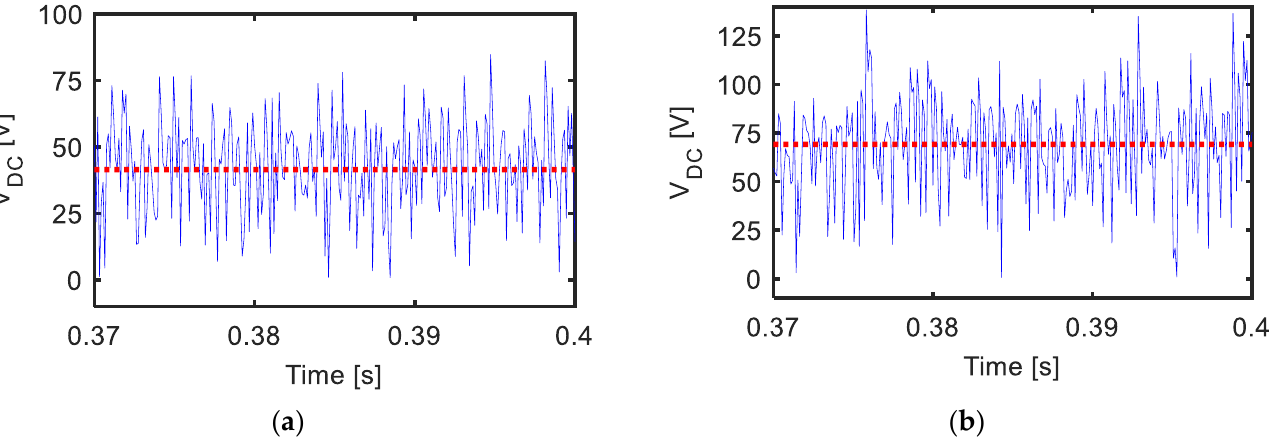
Figure 12. The DC-link current at a motor current of 3 A, current angle of 25°, and supply line voltages of ( a ) 40 V and ( b ) 50 V. The red dotted line represents the mean value.